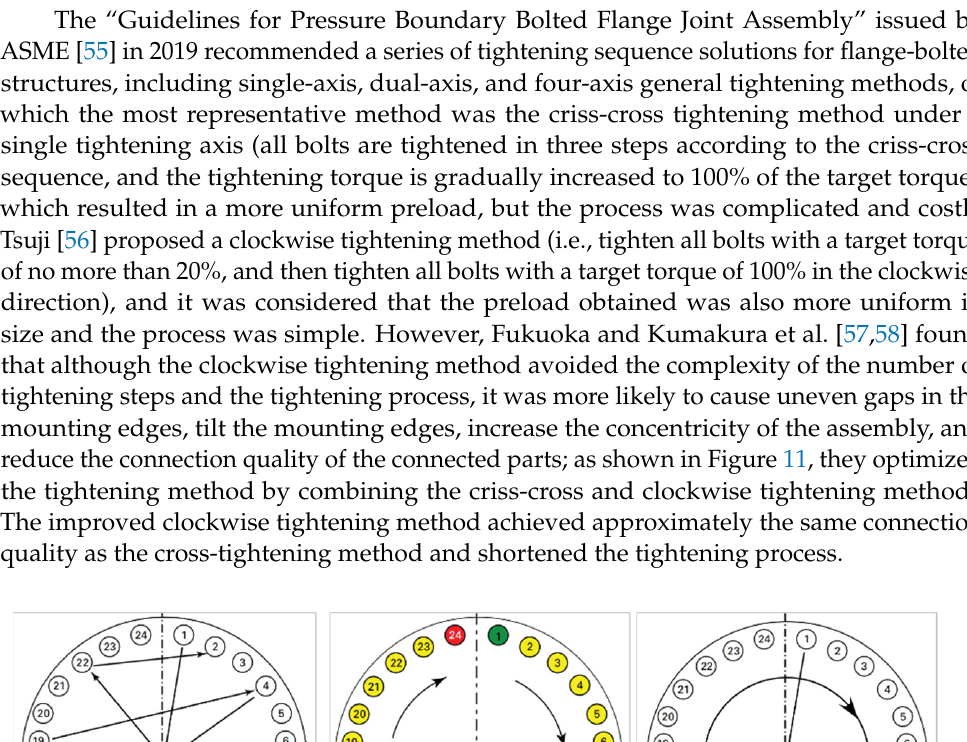
Figure 10. Finite element model of 16 bolts and the sequence diagrams of cross-tightening methods A and B [54].